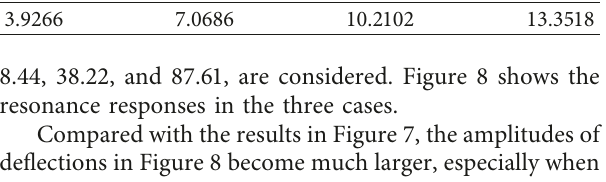
Figure 11: The model for a clamped-pinned PCF.